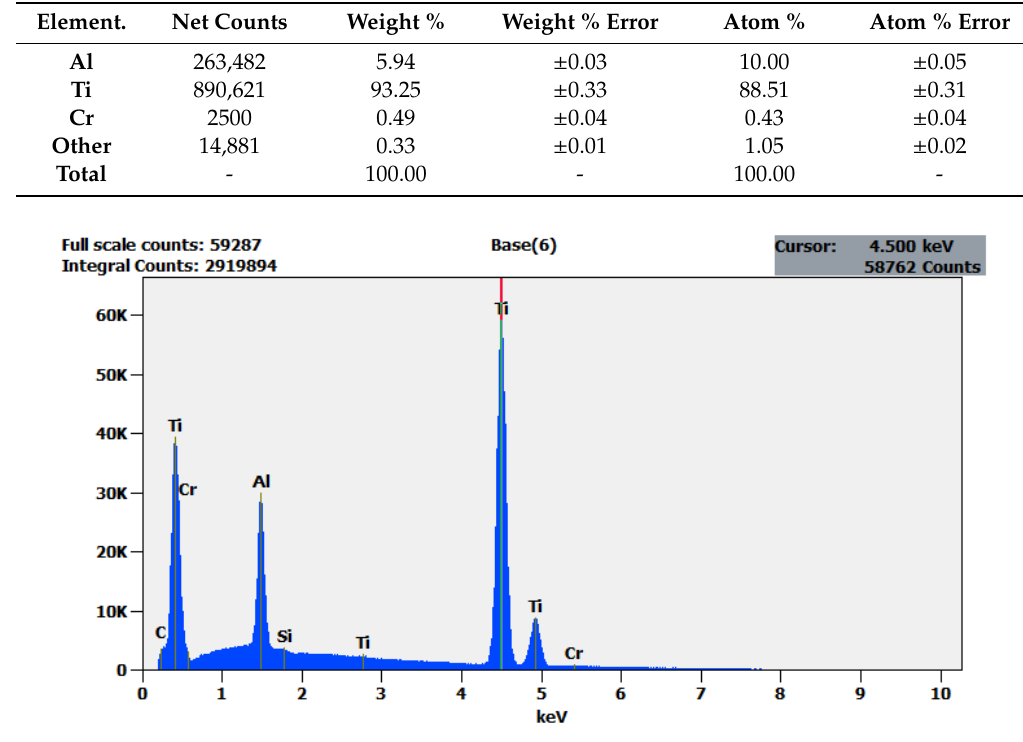
Figure 1. EDS analysis of Titanium Grade 5.